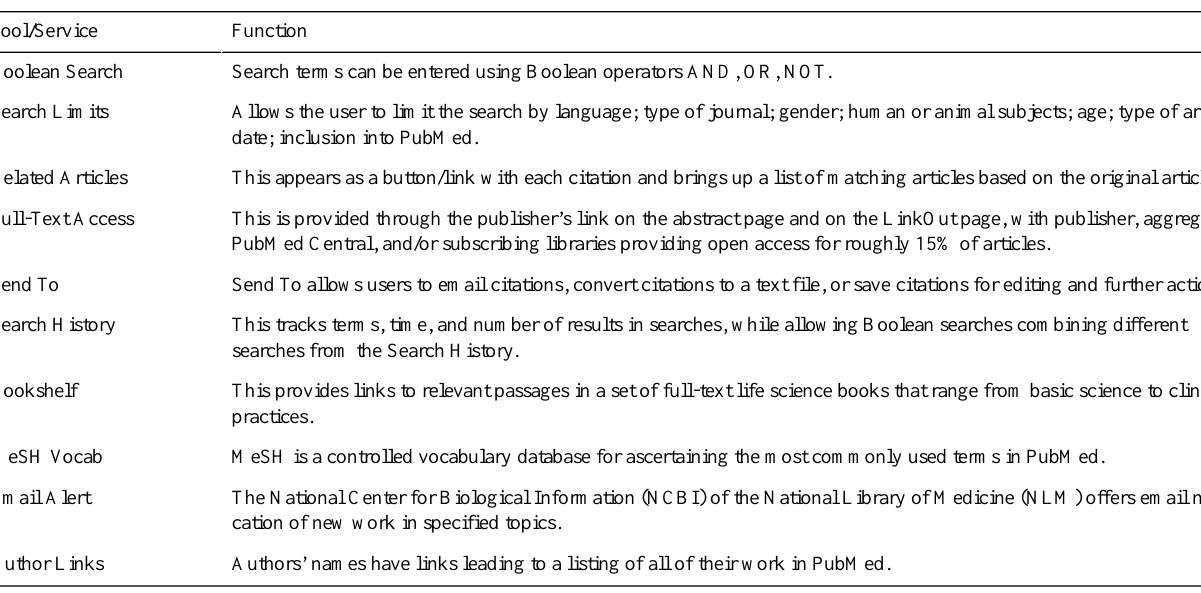
Table 1. PubMed tools and services introduced to participants